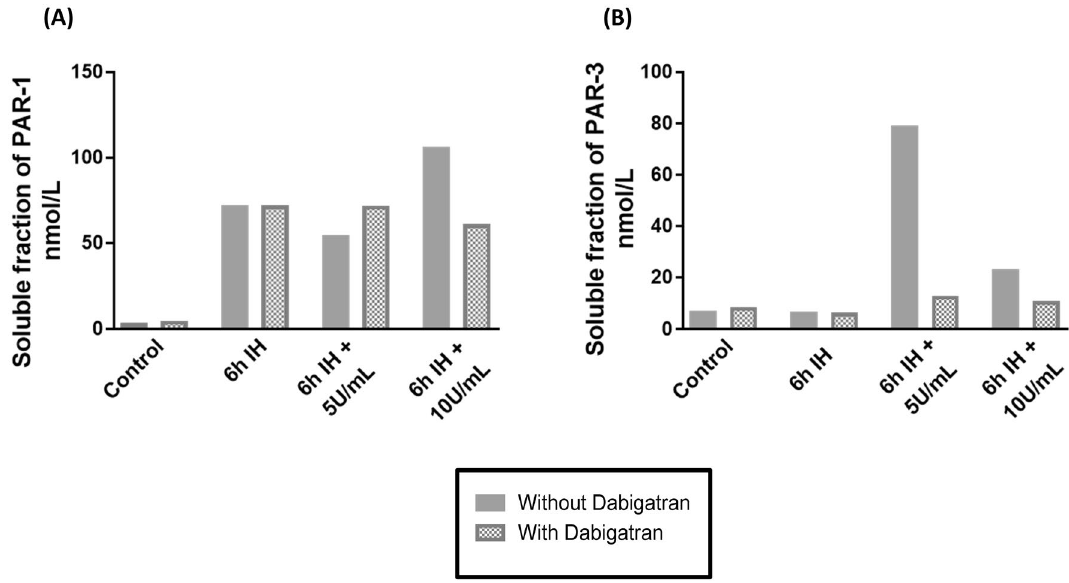
Figure 7. Evaluation of the expression of the soluble fraction of PAR-1 ( A ) and PAR-3 ( B ) in the supernatant of HBEC-5i after pretreatment with dabigatran in our cycles of IH with or without thrombin at 5U/mL and 10U/ mL ( n = 6, N = 2). IH intermittent hypoxia, PAR: protease activated